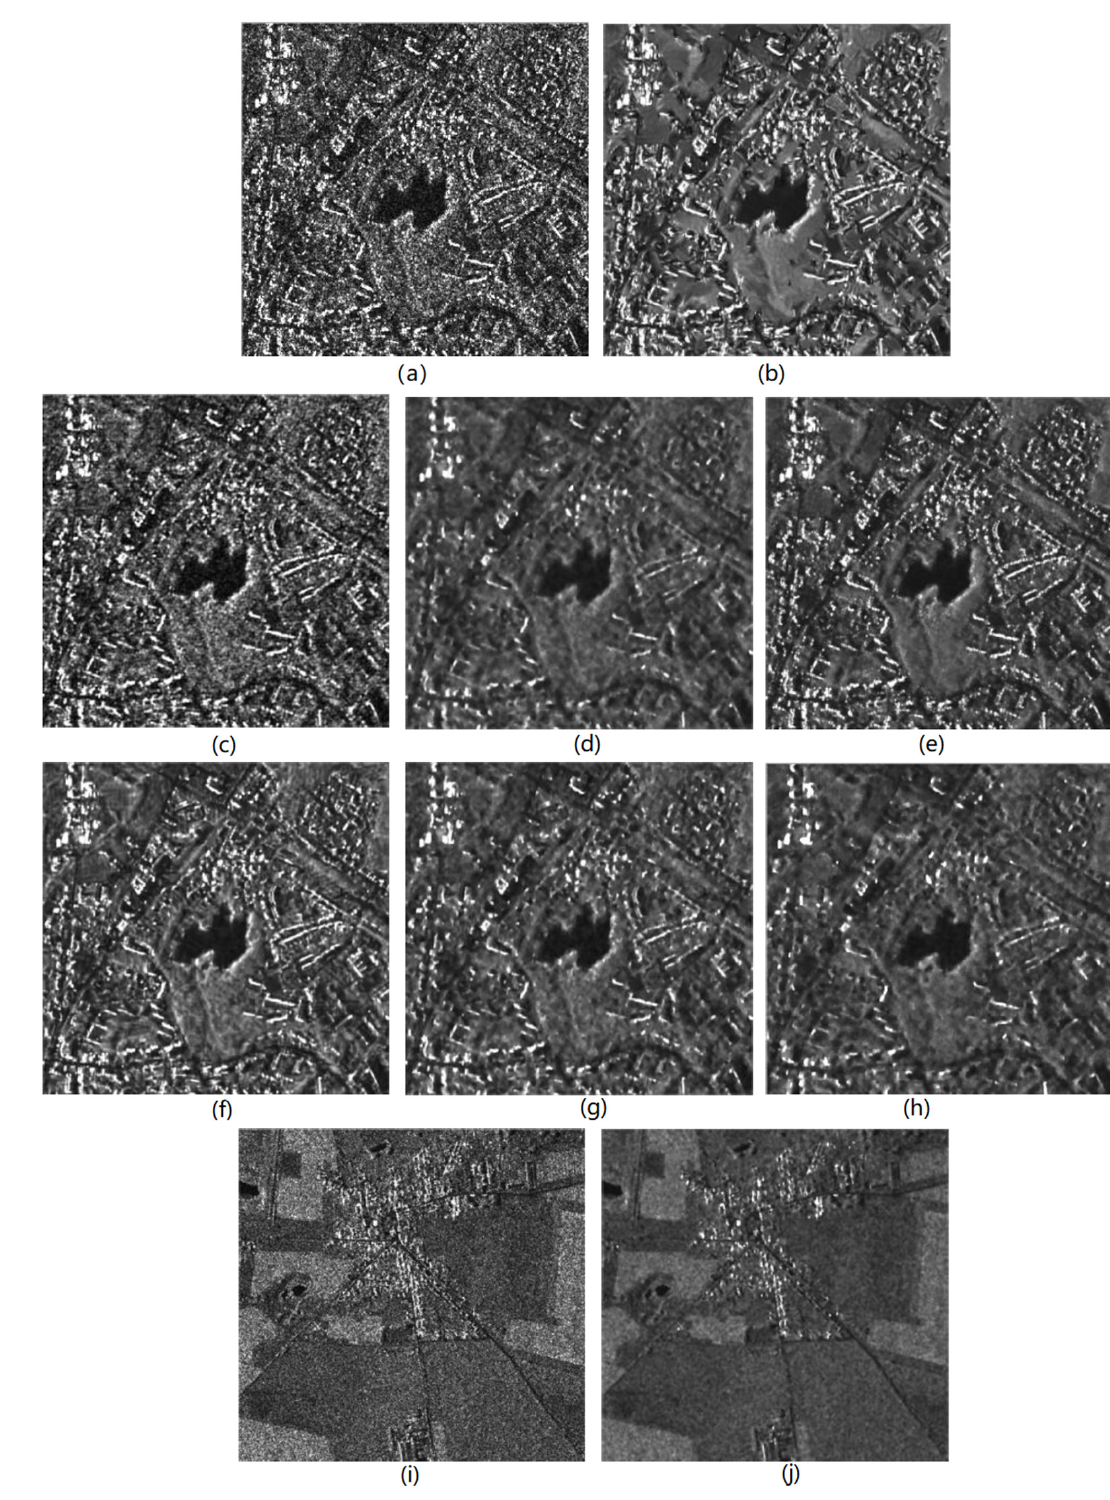
Figure 7. The despeckling result of the TerraSAR dataset. ( a ) Speckled image. ( b – g ) The images filtered by the PPB filter, the SAR-DRN filter, the BM-NR-DL filter trained with one image, the NR-SAR-DL filter, the MSAR-BM3D filter, and the BM-NR-DL filter trained with bi-temporal images, respectively. ( h ) Another time phase image filtered by the BM-NR-DL filter pre-trained with bi- temporal images. ( i ) Speckled image of a new region. ( j ) The image filtered by the BM-NR-DL filter pre-trained with bi-temporal images.